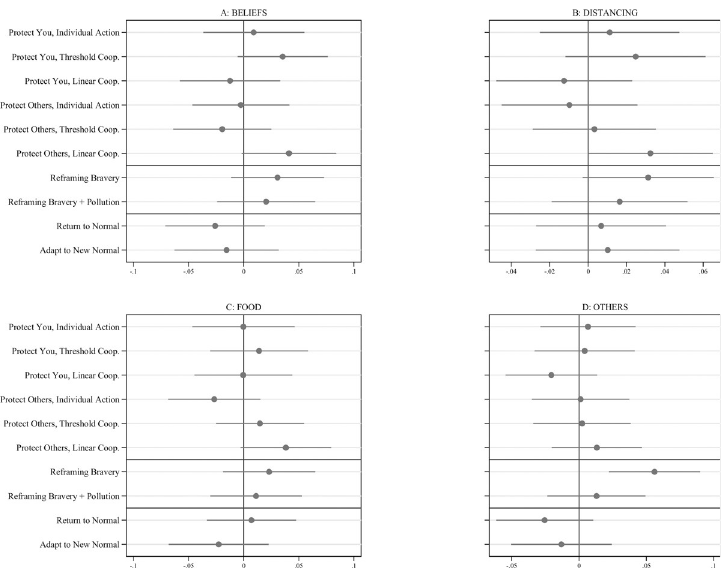
Fig 1. Covariate-adjusted treatment effects estimated using OLS regression with robust Huber-White standard errors. Estimates displayed with 95% confidence intervals. Each panel shows the effect of each treatment message relative to the Baseline Informational condition for a primary outcome scale. All outcomes scales were coded such that higher values indicate more positive attitudes or intentions toward social distancing.